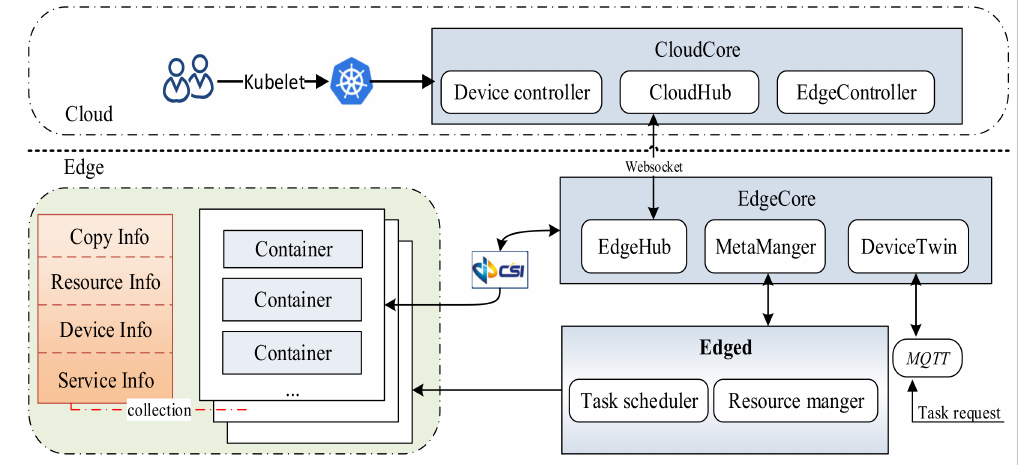
Figure 7. Task rescheduling process, where MQTT is message queuing telemetry